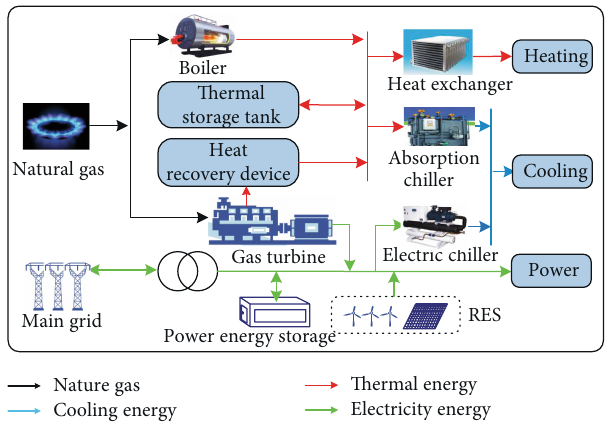
Figure 2: Basic structure of